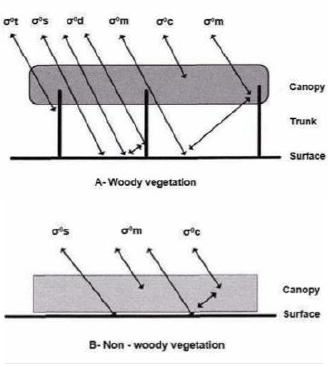
Figure 2. Backscattering sources for a vegetated wetland (Catry et al. 2016).